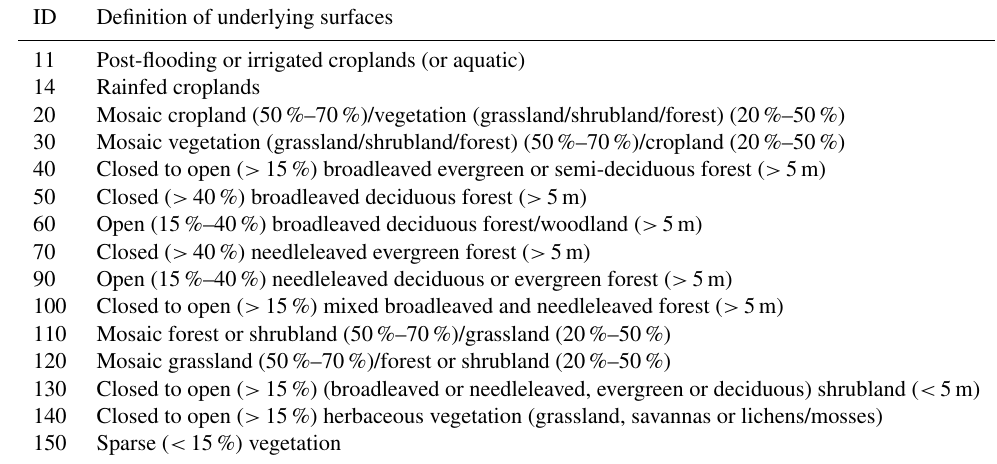
Table 6. Classification of underlying surfaces (land cover types).